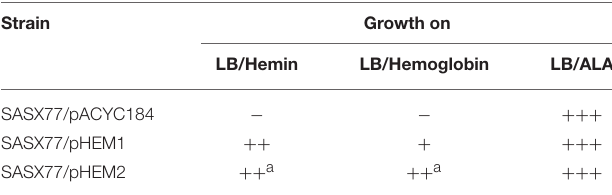
TABLE 1 | Assessment of HemR1 and HemR2 activity in hemin and hemoglobin transport in E. coli 1 hemA strain SASX77. Strain Growth on LB/Hemin LB/Hemoglobin LB/ALA SASX77/pACYC184 ++ a +++ − No growth. + ∼ 10mm diameter growth zone around the discs. ++ 20–25mm diameter growth zone around the discs. +++ > 30mm diameter growth zone around the discs. a Growth as single colonies.